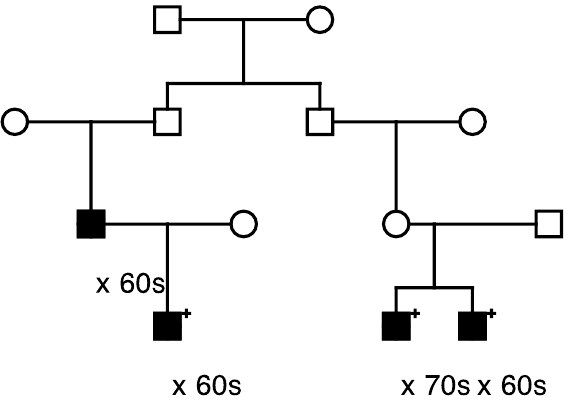
Figure 6. High-risk prostate cancer pedigree segregating a rare BRCA1 variant.